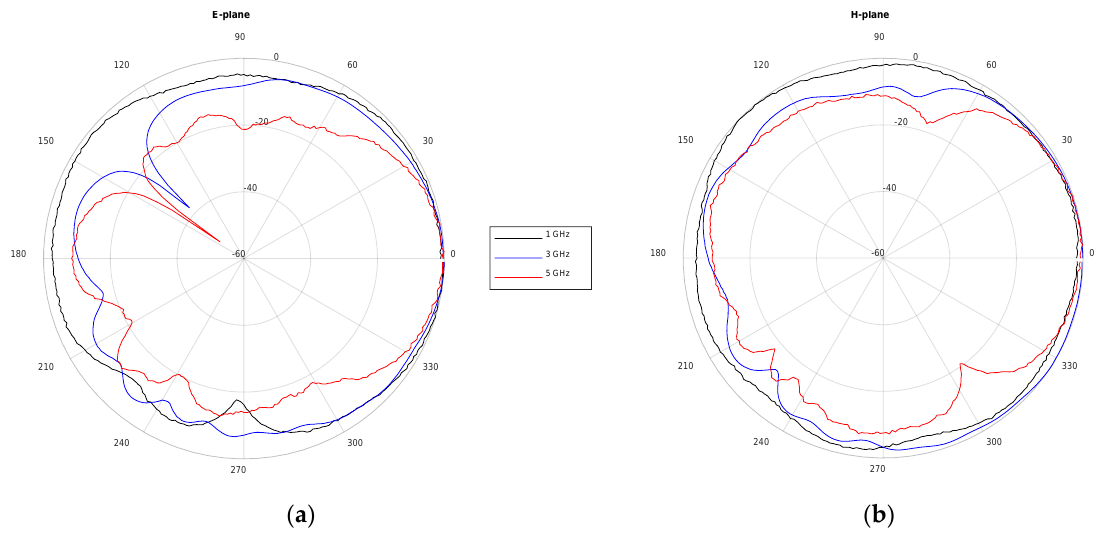
Figure 4. Measured antenna radiation pattern at specific frequency points: ( a ) E-plane; ( b ) H-plane.